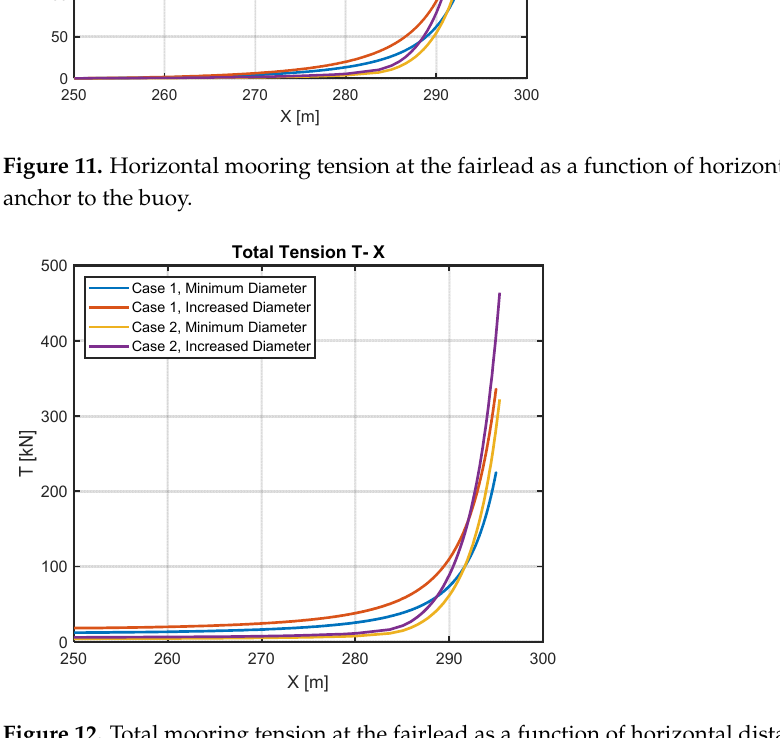
Figure 13. Top angle at the fairlead as a function of horizontal distance from the anchor to the buoy. It is observed that in all the cases studied, the tensions increase with the increasing distance from the anchor to the vessel ( X ). Moreover, for the same system, with a greater diameter, the response behaviours are similar, but with higher values of vertical, horizon- tal and total tension. This happens because for higher diameters the weight of the line increases. Moreover, it is also found that the three components cable shows almost con- stant tensions for small horizontal displacements, but between 280 and 290 m, it reaches a point where the tension increases rapidly with small displacements. Figure 13 shows the relation between the top angle and the horizontal excursion. Un- like tensions, this parameter does not change as the diameter of the lines increases, how- ever, different responses can be observed between Cases 1 and 2. 4.1.1. Initial Position (Zero Offset) Considering the different pre-tensions ( T H 0 ,i ) and using the relations between the hor- izontal tension and the horizontal distances ( T H − X and T H − x ), the horizontal distance from the anchor point to the fairlead ( X 0 ) and from the touch-down point to the fairlead ( x 0 ) in the equilibrium position, is obtained. Moreover, the static tension in the initial po- sition ( T 0 ) is calculated using the relation 𝑇 = (cid:3493)𝑇 (cid:3027) + 𝑇 (cid:3009) .